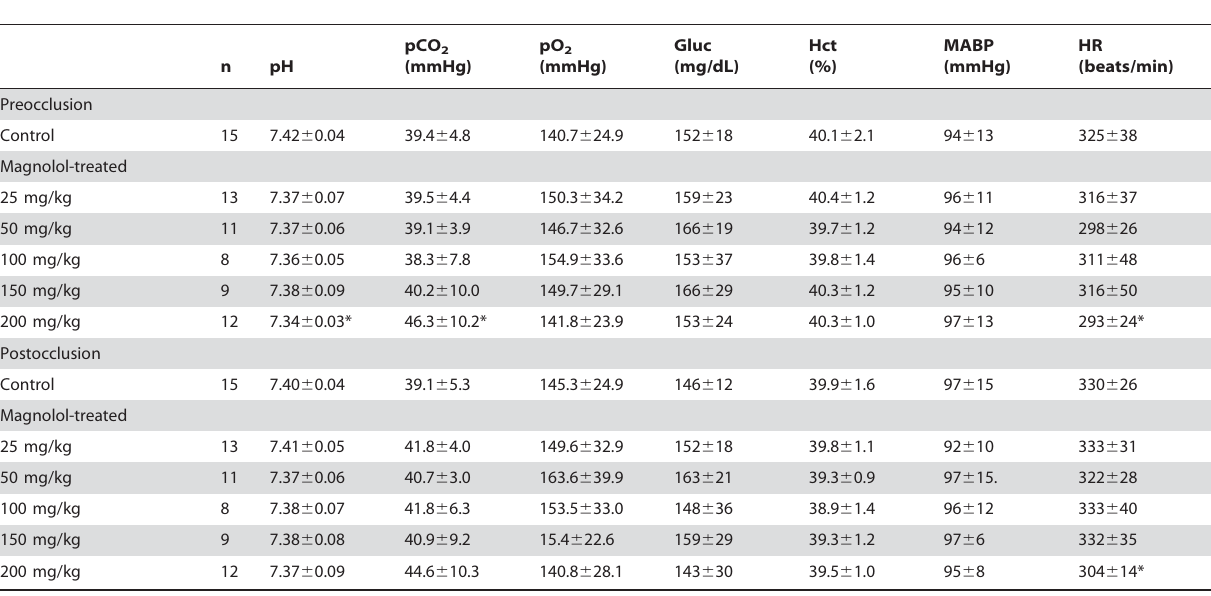
Table 1. Physiologic parameters before (preocclusion) and after (postocclusion) permanent middle cerebral artery occlusion (PMCAO) between animals pretreated with magnolol versus vehicle (PEG 400)-treated controls.